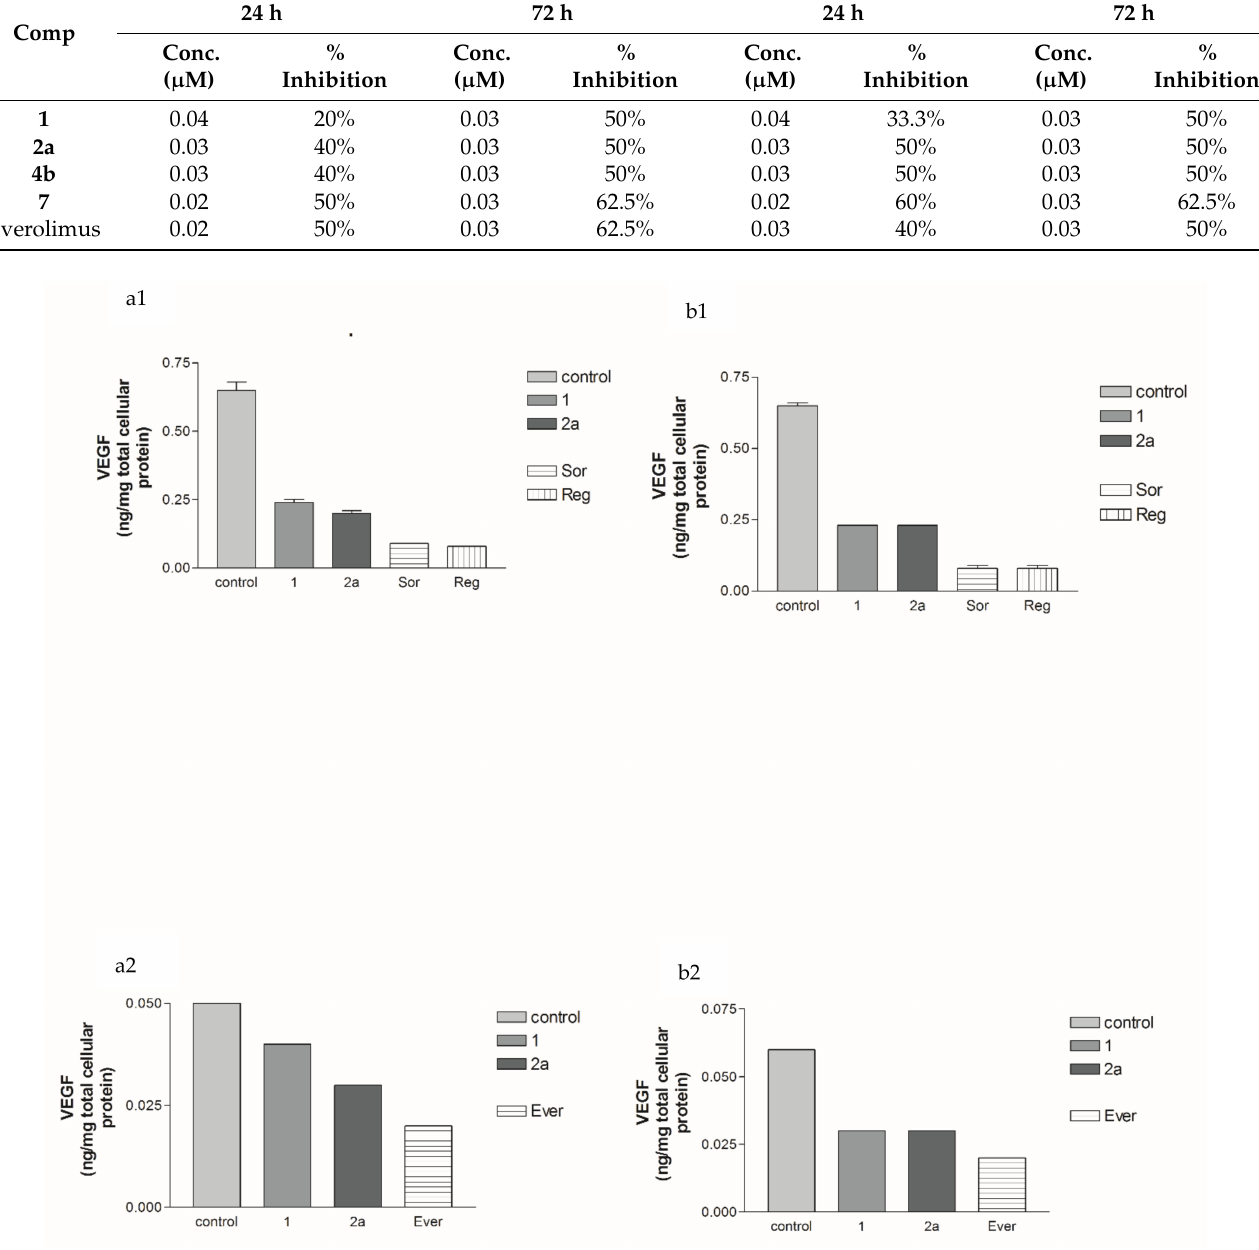
Figure 4. Effects of 1 and 2a and reference medications on VEGF protein expression level (ng/mg tissue protein) in HEPG2 and MCF-7, where ( a1 , a2 ) at 24 h and ( b1 , b2 ) 72 h, all therapies were provided for 3 successive days. Results are given as mean ±